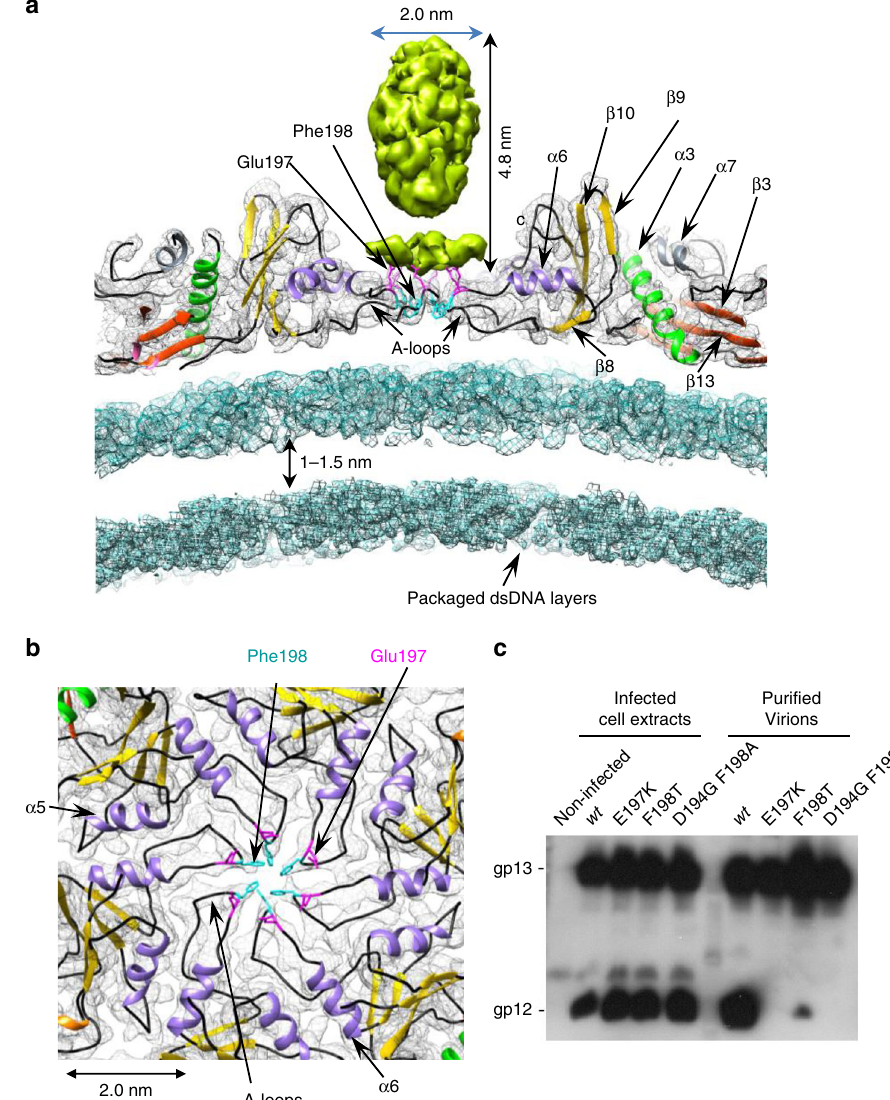
Fig. 4 Interaction of the accessory protein gp12 with the MCP A-loops in the hexons. a Central cross section through the hexon. b Arrangement of A-loops in the centre of the hexon. Residues involved in the interaction with gp12 are labelled. c Western blot of crude extracts of B subtilis bacteria infected with SPP1 phages carrying gp13 with the amino acid substitution(s) displayed above the gel lanes (left) and of puri fi ed SPP1 viral particles with the mutant MCP forms (right). Note that gp12 is produced in all infections but binds only stably to wild-type particles. The phage encoding gp13 Asp194Gly Phe198Ala is an escape mutant isolated from the poorly growing mutant phage SPP1gp13